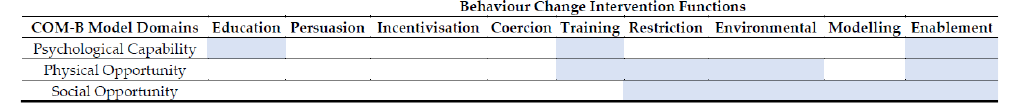
Figure 2. Mapping of COM-B Model barriers and potential intervention functions. Where the COM-B domain aligns with potential intervention functions is highlighted in blue.